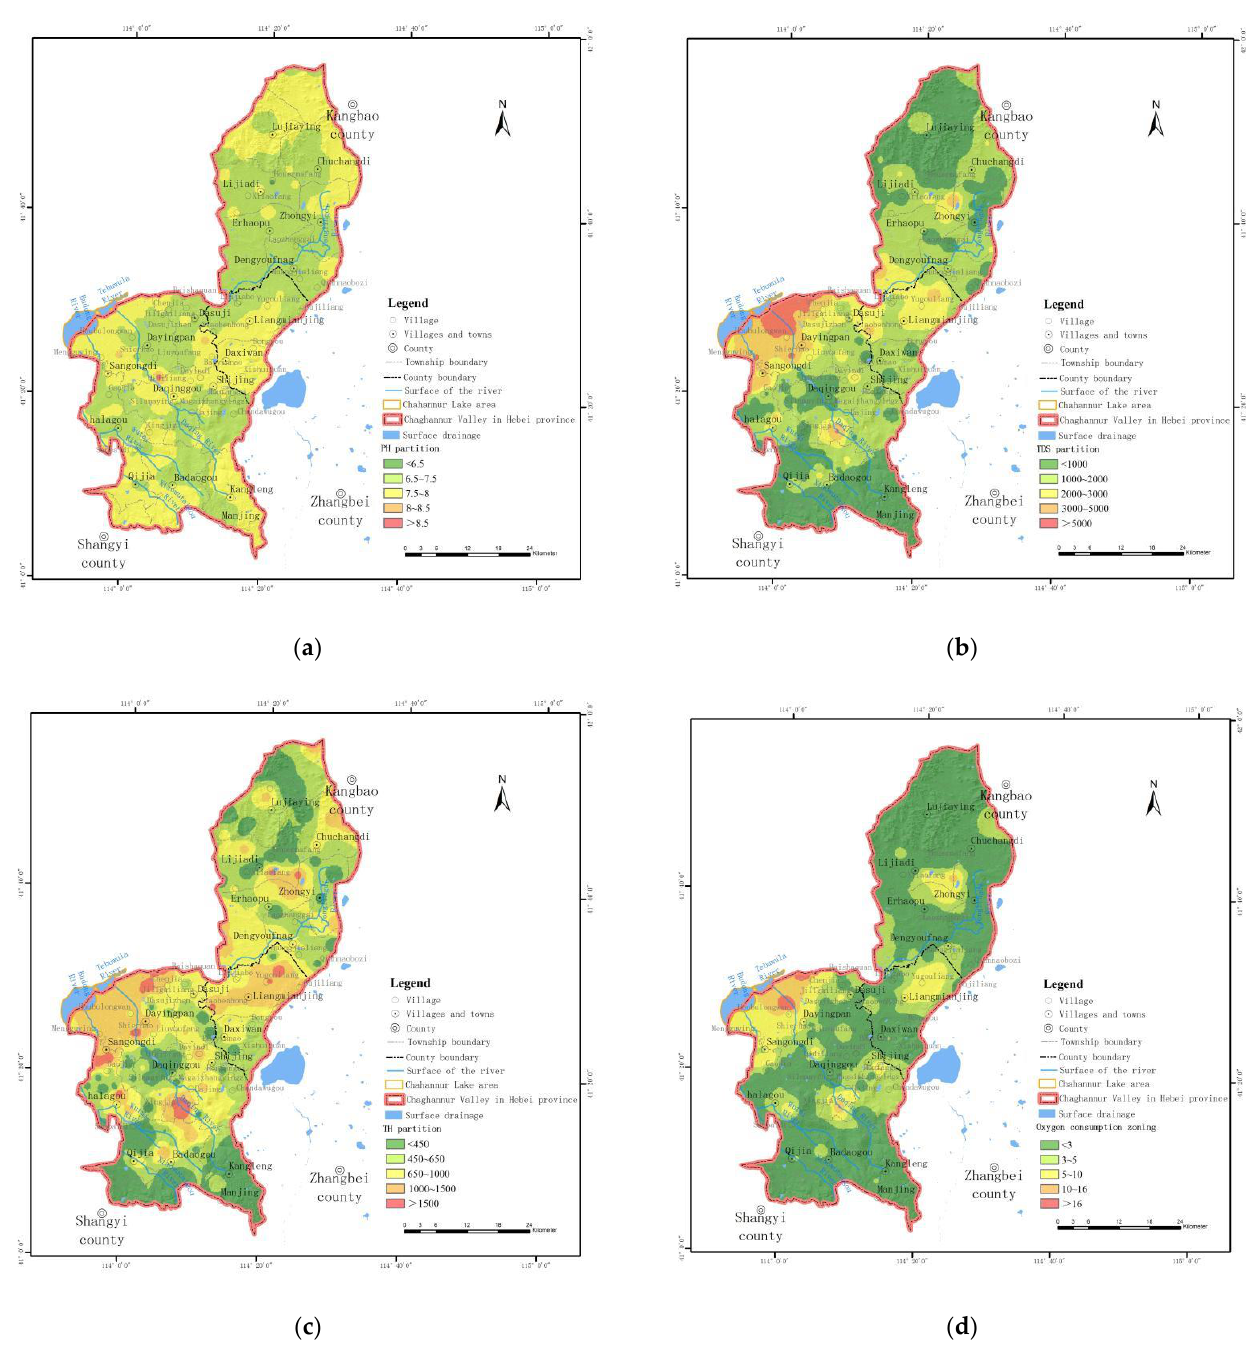
Figure 6. Spatial distributions of ( a ) pH, ( b ) TDS, ( c ) TH and ( d ) COD in the Chahannur Basin